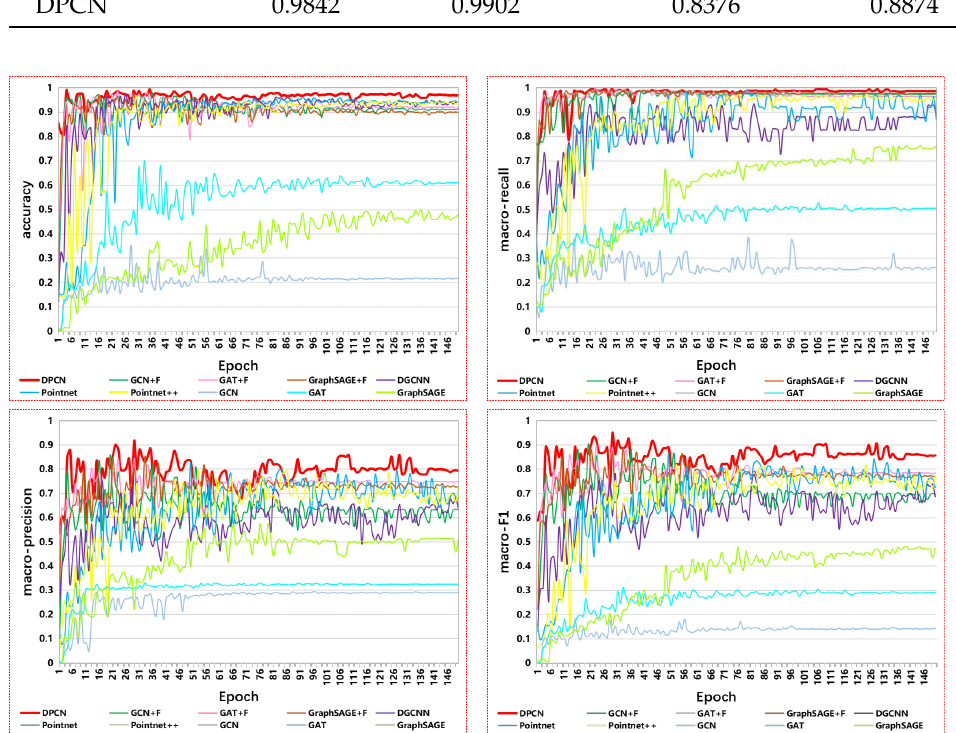
Figure 4. The values of each evaluation metric of our proposed DPCN, graph neural network methods(GCN+F, GAT+F, GraphSAGE+F, GCN, GAT, GraphSAGE), and point cloud neural network methods(PointNet, PointNet++, DGCNN) vary with the increase of the number of